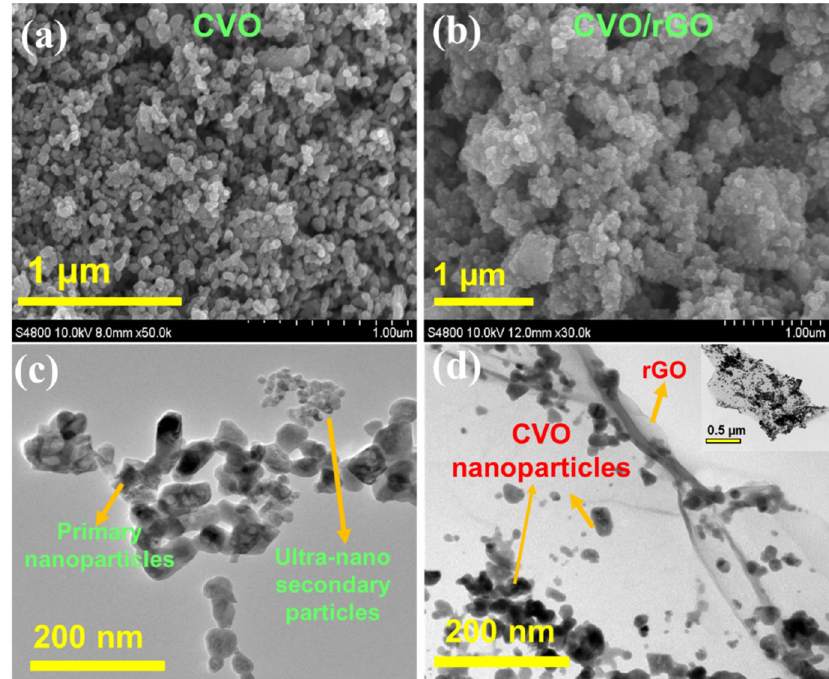
Figure 2. ( a , b ) SEM images and ( c , d ) TEM images of bare CoV 2 O 4 and rGO-wrapped CoV 2 O 4 materials (inset of Figure 2d is a large magnification TEM image of CVO/rGO sample).